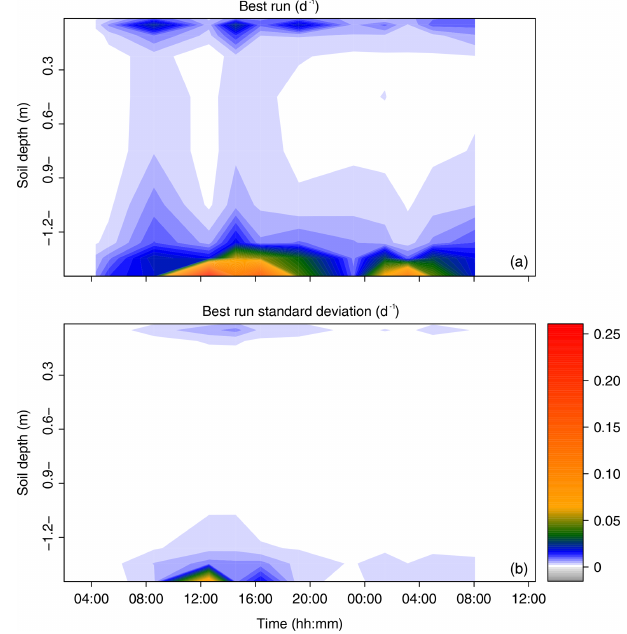
Figure 7. Time series of the profiles of root water uptake per unit soil volume (sink term, d − 1 ) computed with the statistical model SIAR (a) . Panel (b) reports the variance of the estimated sink term (1 standard